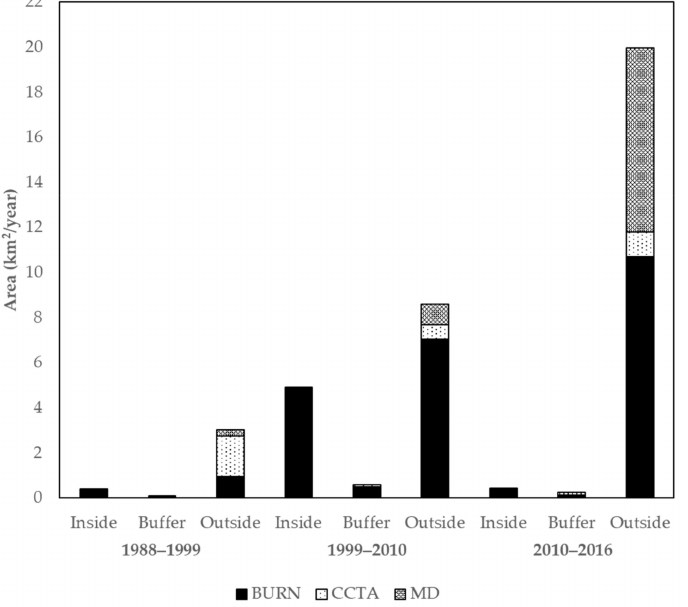
Figure 6. The area of major disturbance classes, per year, in inside, buffer zone, and outside of the reserve, during 1988–1999, 1999–2010, and 2010–2016. BURN = burned area, CCTA = clearcutting for timber or agriculture, and MD = mixed